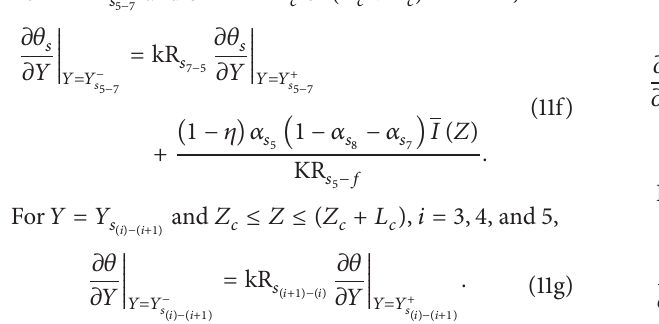
For 𝑌 = 𝑌 𝑠 and 0 < 𝑍 < 𝑍 𝑐 or (𝑍 𝑐 + 𝐿 𝑐 ) < 𝑍 < 𝐿 5−7